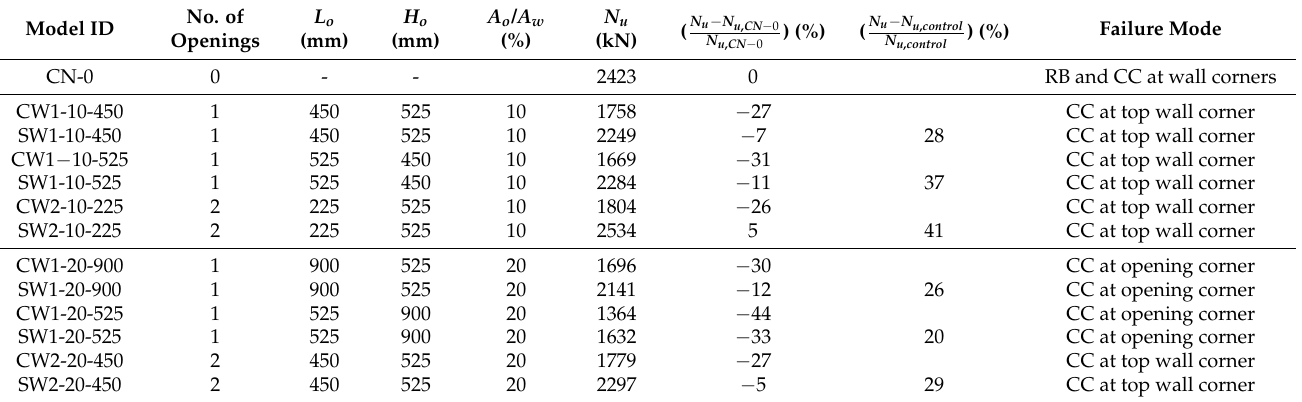
Table 5. Results of wall models with various opening